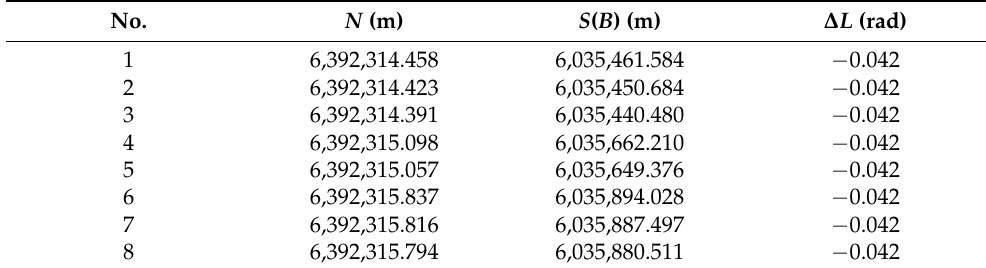
Table 2. Values of the radiuses of curvature perpendicular to the meridian ( N ) and the meridian arc lengths from the equator to the arbitrary latitude ( S(B) ) for the reference points, as well as the difference in longitude between the reference points in the WGS–84 system and the points with a length of L 0 ( ∆ L ).